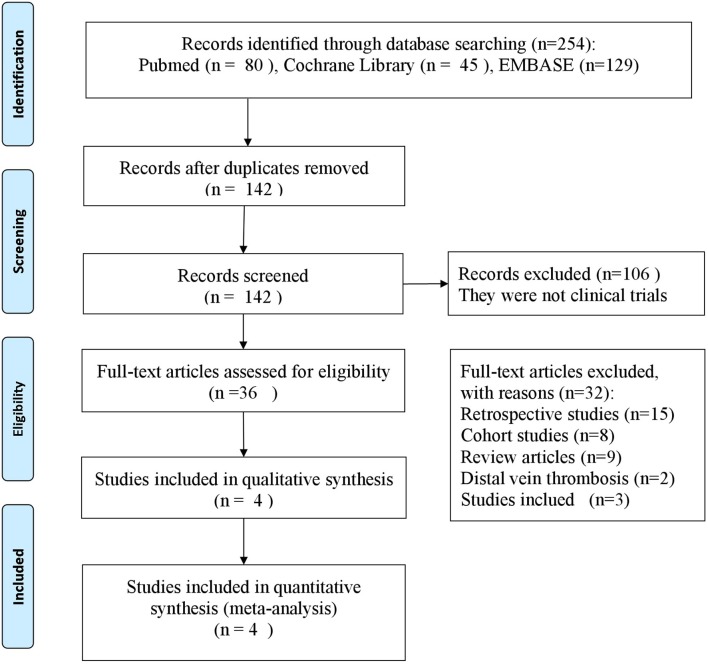
Flow chart of the selection of studies.